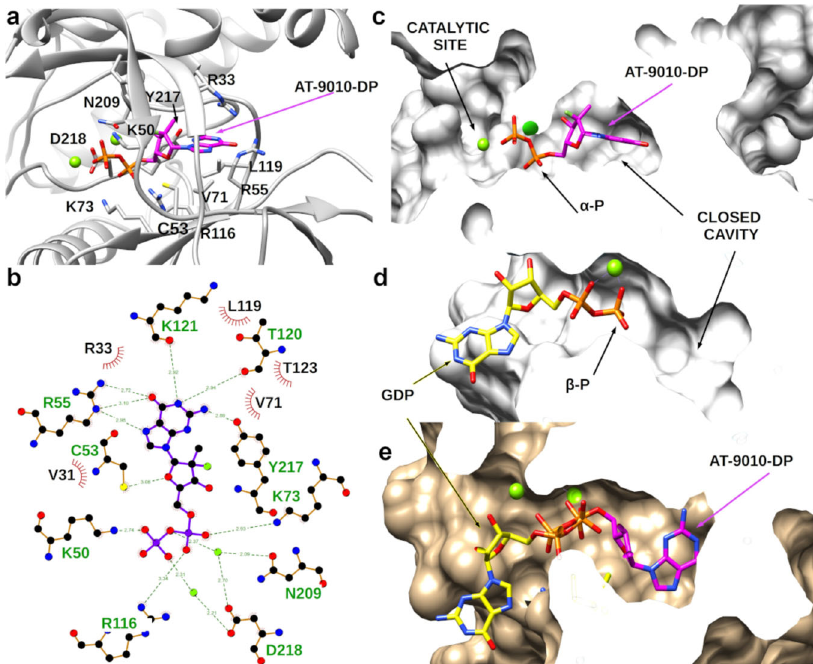
Fig. 4 Structural basis for NiRAN inhibition of the SARS-CoV-2 by AT-9010. a Binding of AT-9010 5 ’ -diphosphate (AT-9010-DP) in the NiRAN domain. Interacting residues are labeled and shown in stick representation. b Ligplot 2D representation of the detailed interactions of AT-9010-DP binding in the NiRAN cavity. c Surface representation of the NiRAN sliced orthogonally in Z showing AT-9010-DP engulfed in the cavity. d Surface representation of the NiRAN sliced orthogonally in Z showing GDP binding (PDB 7CYQ); Orientation is rotated by ~ + 90° compared to c . e Superimposition of GDP and AT- 9010-DP showing the overlap of the α -phosphate of AT-9010 with the β -phosphate of GDP and Mg 2 + in the two structures, same orientation as d . Color code is as follows: AT-9010, magenta sticks; GDP, yellow sticks; and Mg 2 + , light